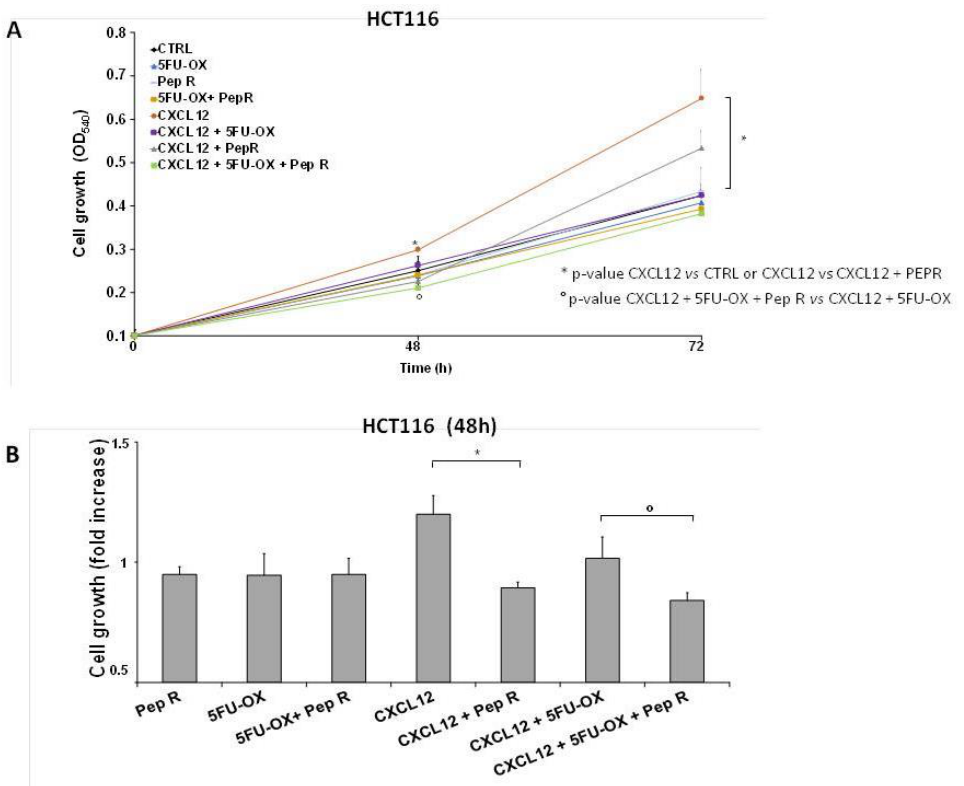
Figure 3. Peptide R impairs cell growth and potentiates in vitro CT/RT-CT efficacy. HCT116 were grown in the presence of CXCL12 (100 ng/mL), 5FU-OX (3.5 – 4.5µM. respectively), Pep R (10 µM). ( A ) Graph showed showing Pep R (10 µM) enhanced significantly 5-FU-OX effect at 48 h ( B ). Bars depict mean ± SD of three independent experiments. p -value < 0.05 (*) was considered statistically significant (Kruskal- Wallis test followed by Dunn’s multiple comparison ).